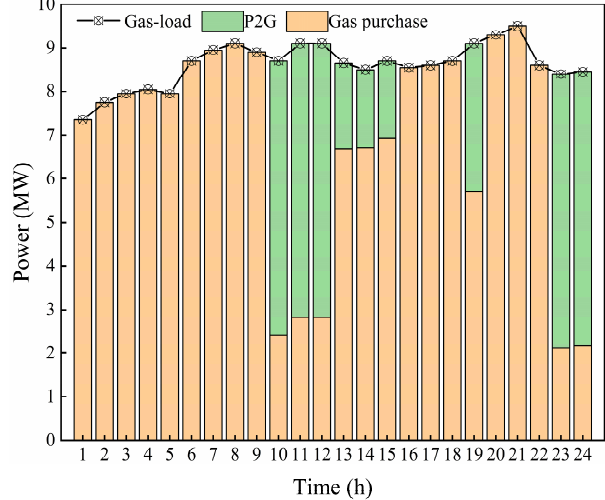
Figure 17. PIES 1 gas network for scenario 4.